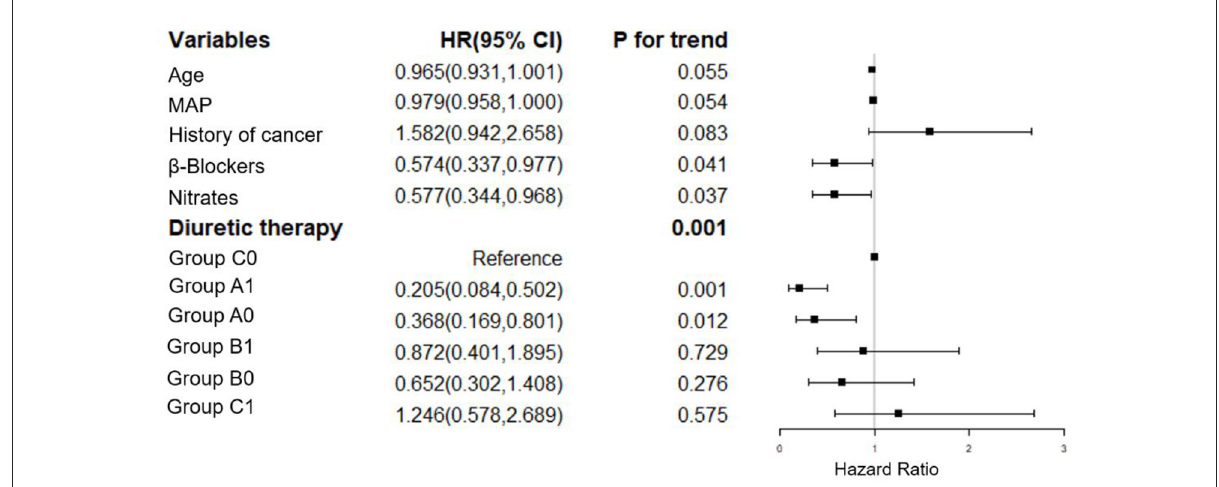
FIGURE2 Cox regression analysis of the associations between 7-day cumulative mortality and the clinical findings. MAP, mean arterial pressure; Group A1: < 100 mg/d equivalent doses of furosemide plus TLV; Group A0: < 100 mg/d equivalent doses of furosemide only; Group B1: ≥ 100 and < 200 mg/d equivalent doses of furosemide plus TLV; Group B0: ≥ 100 and < 200 mg/d equivalent doses of furosemide only; Group C1: ≥ 200 mg/d equivalent doses of furosemide plus TLV; Group C0: ≥ 200 mg/d equivalent doses of furosemide